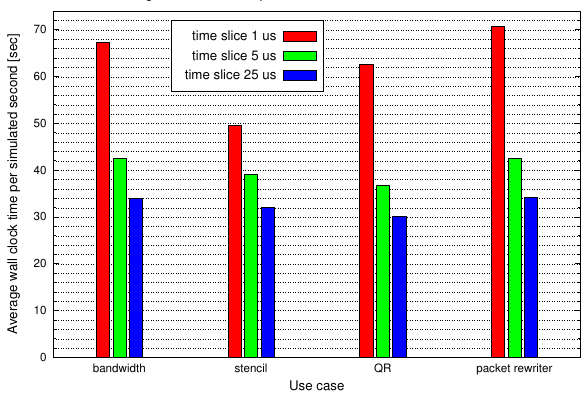
Figure 5: Average wall clock times per simulated second.